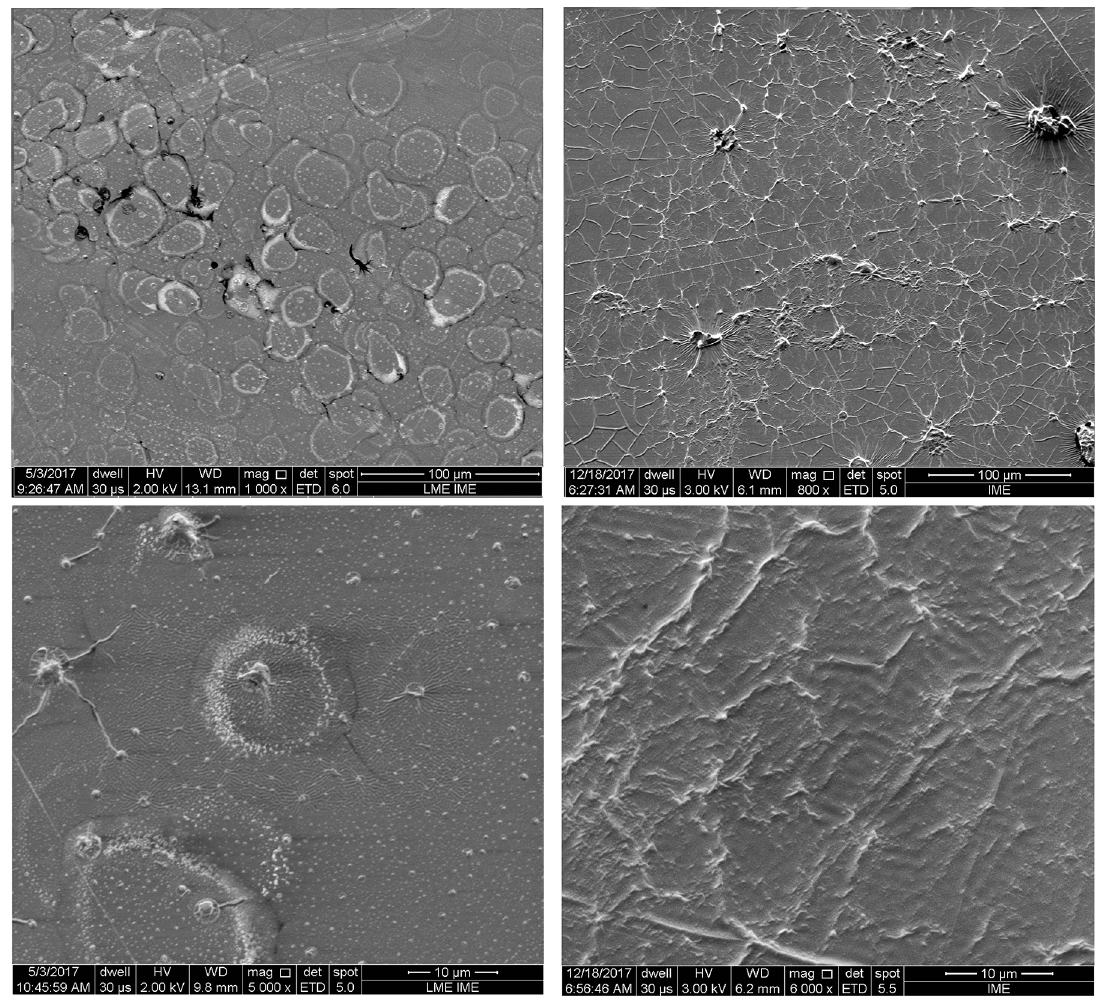
Figure 6. FEG-SEM images of the untreated and treated nanocomposites cryo-sectioned : (6a) agglomerated particles of the untreated PMMA/SiC 1%nanocomposites, scale 100µm; (6b) disperse particles present into the treated PMMA/SiC 1% nanocomposites, scale